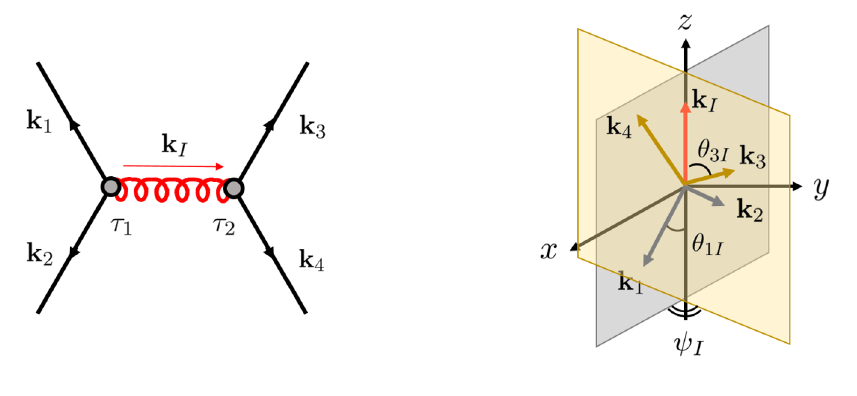
Figure 9 . Left: the leading contribution of the amplified massive spin-2 field to h ζ 4 i . Right: the kinematic